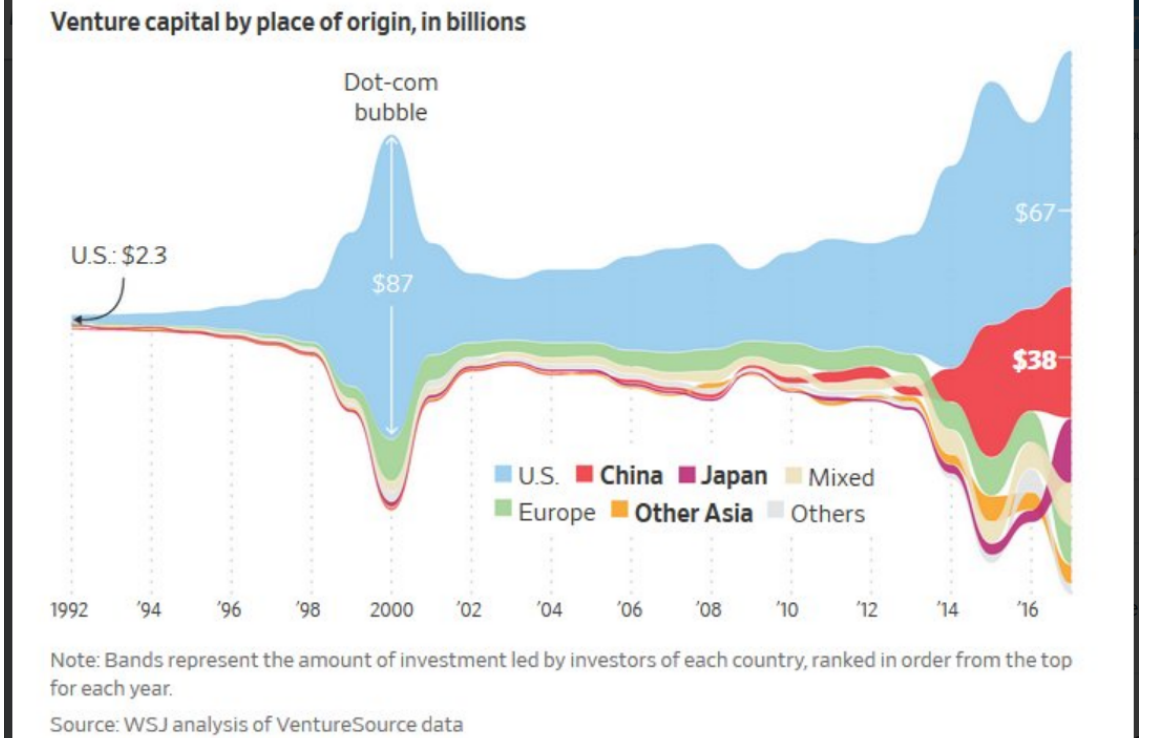
Fig. 10 . Venture Capital Flow, US$ Billions. Source: Wall Street Journal Venture Source